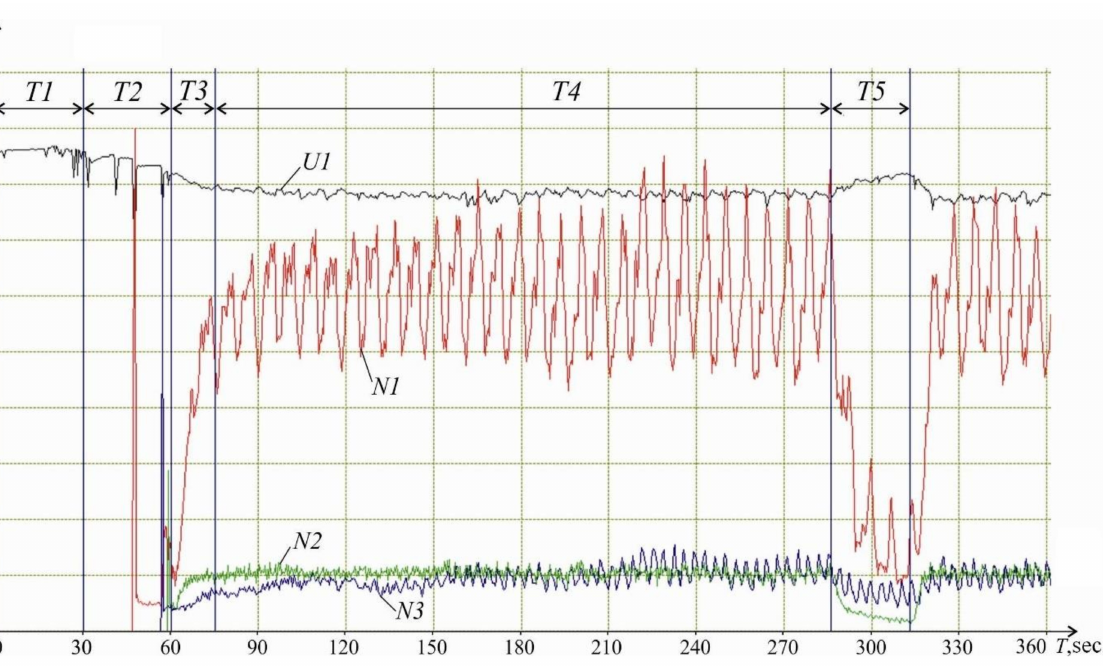
Figure 4. Changing energy parameters of the actuators operating in the Ural-20R combine: U1—input phase voltage, V; N1—active power of the cutting disc drive, kW; N2—active power of the fender drive, kW; N3—active power of the portable motion drive, kW; T1—the duration of the “off” state of the combine’s electric motors, s; T2—duration of motors’ start, s; T3—hewing duration, s; T4—duration of steady-state operation mode, s; T5—duration of no-load operation mode,